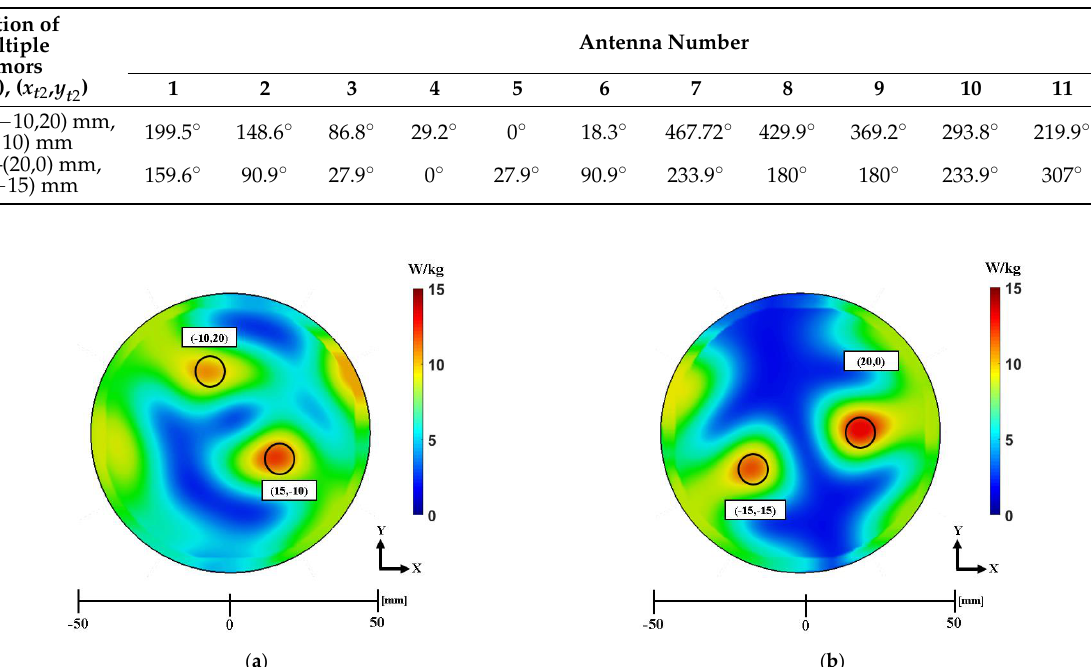
Figure 10. The 2D section of SAR distributions with the phase compensation technique (modified phase, 𝜑 m = 180° ): ( a ) two breast tumors located at (−10,20) mm and (15,−10) mm, ( b ) two breast tumors located at (20,0) mm and (−15,−15) mm.